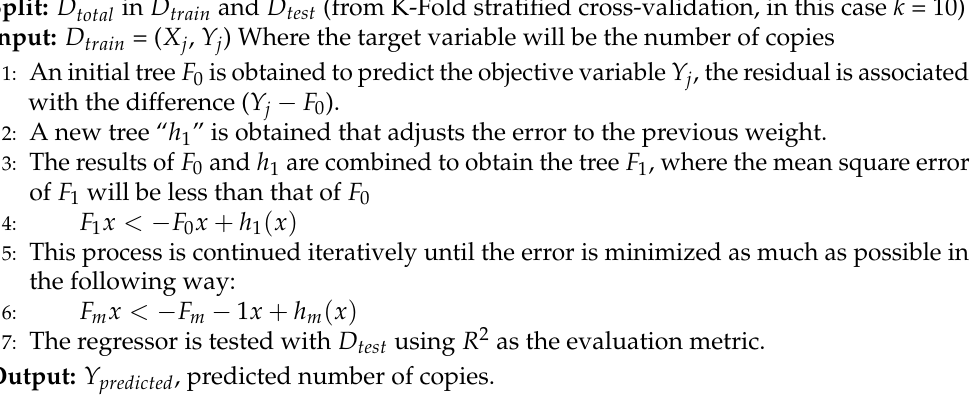
Algorithm 2 Regressor phase